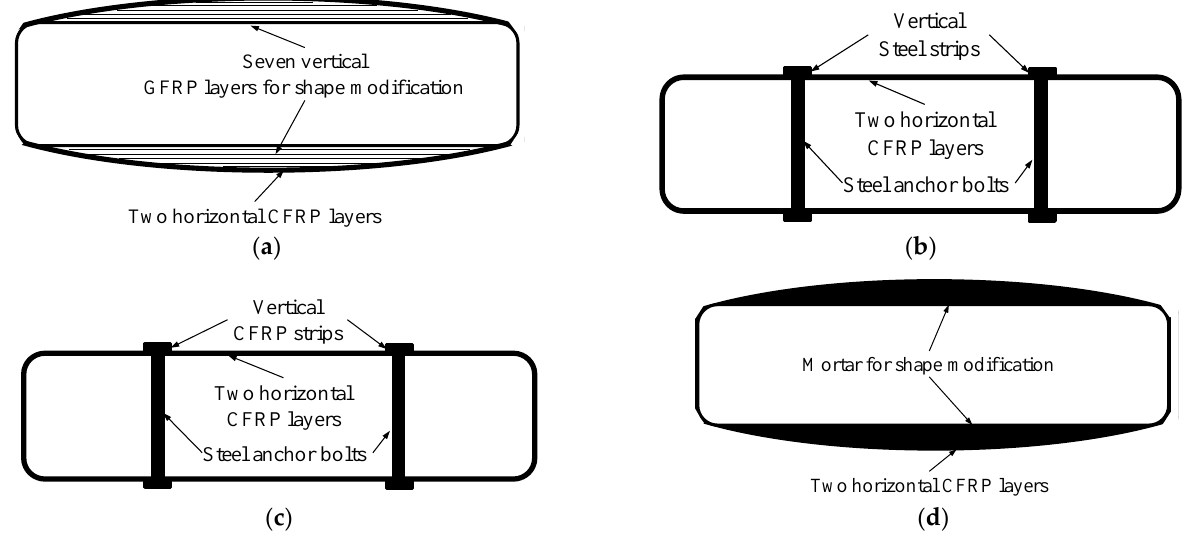
Figure 3. Cross-section of wall-like columns for different strengthening schemes: ( a ) Scheme 1 (7V2H); ( b ) Scheme 2 (4S2H); ( c ) Scheme 3 (4C2H); and ( d ) Scheme 4 (E2H).